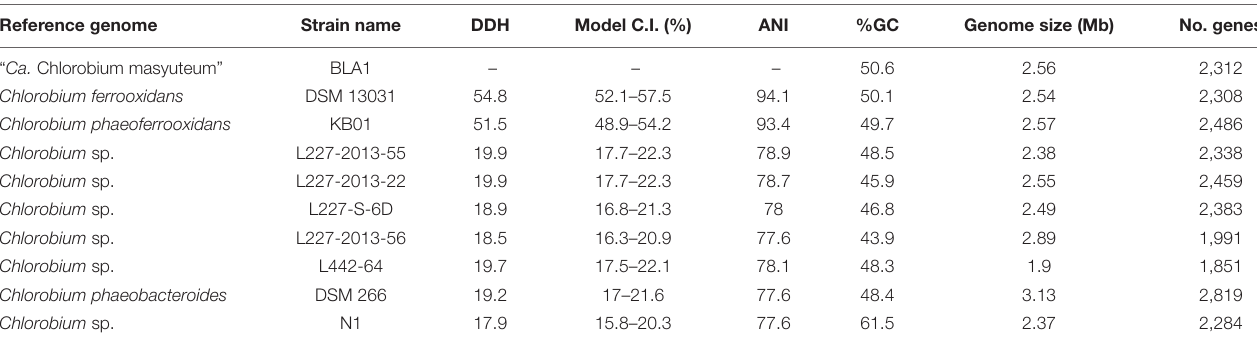
TABLE 2 | Isolate genome characteristics and comparisons to other Chlorobia